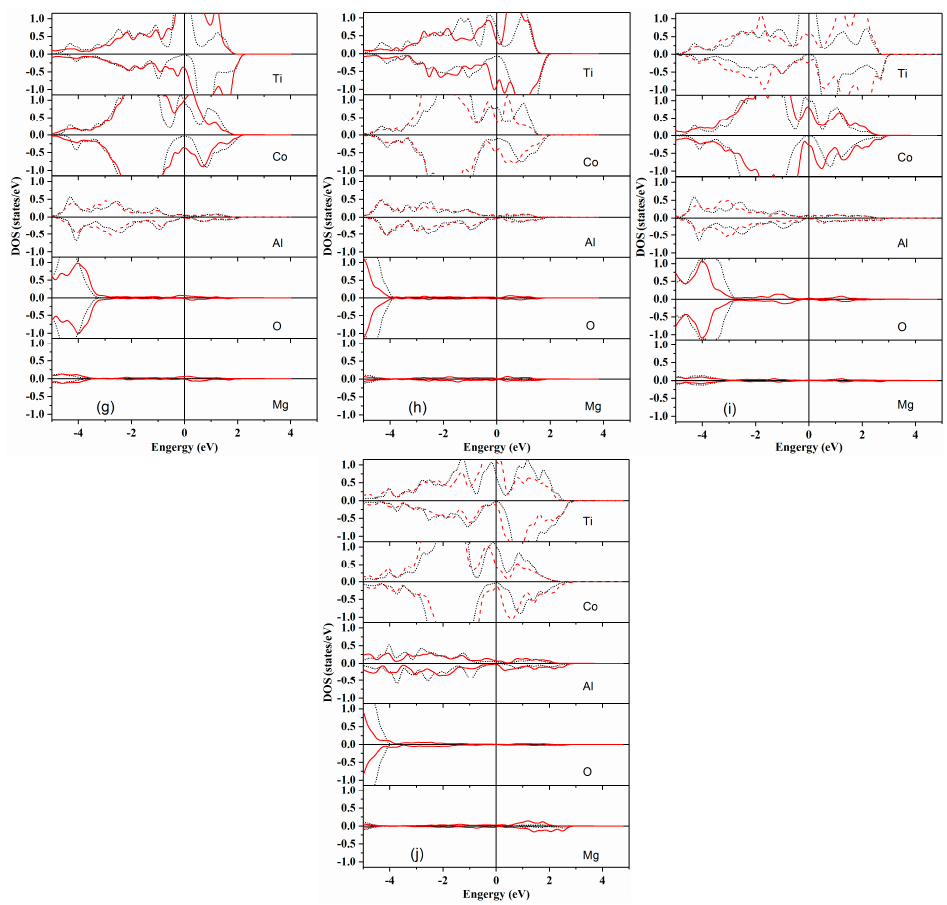
Figure 2. The densities of state (DOS) of the two outermost layer atoms in Heusler alloy Ti 2 CoAl and the first interface layer atom in MgO for 10 potential terminations in Ti 2 CoAl/MgO junctions. ( a )